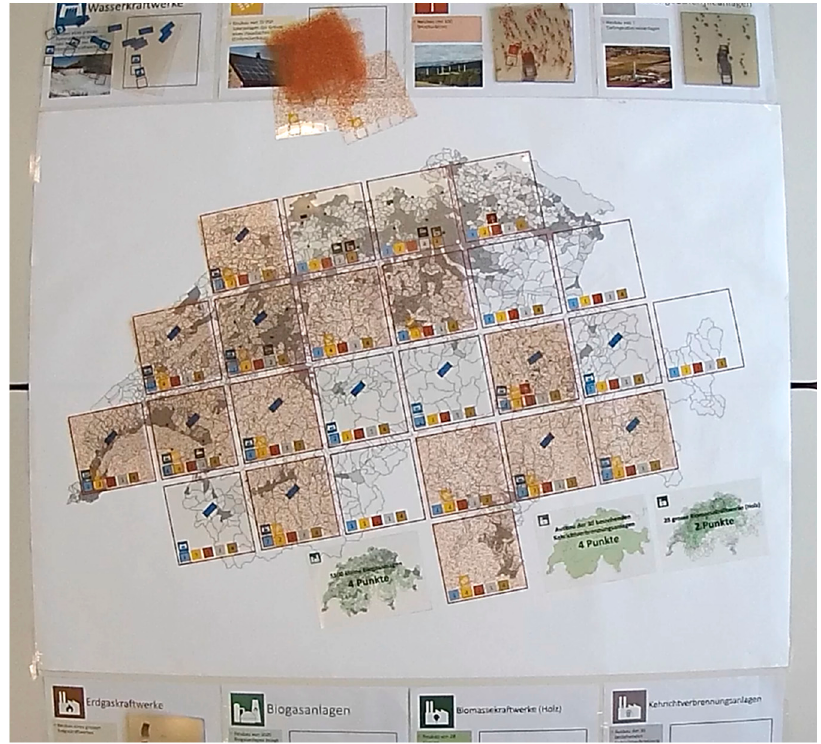
Figure 2. Serious board game on siting a full mix of electricity generation technologies in Switzerland.